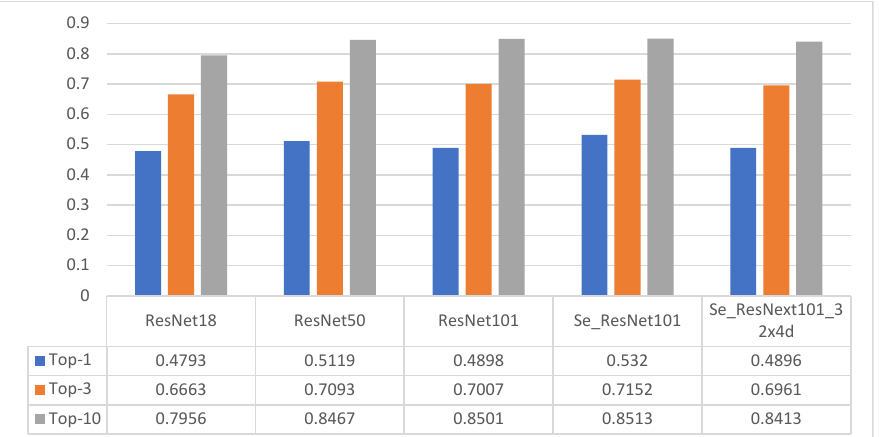
Figure 8. Effects of different backbones used in the dual-backbone feature